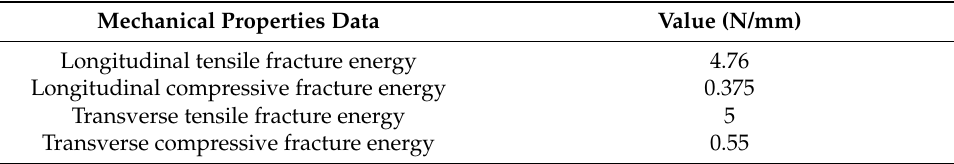
Table 7. Fracture energy of pultruded GFRP I- section beam.